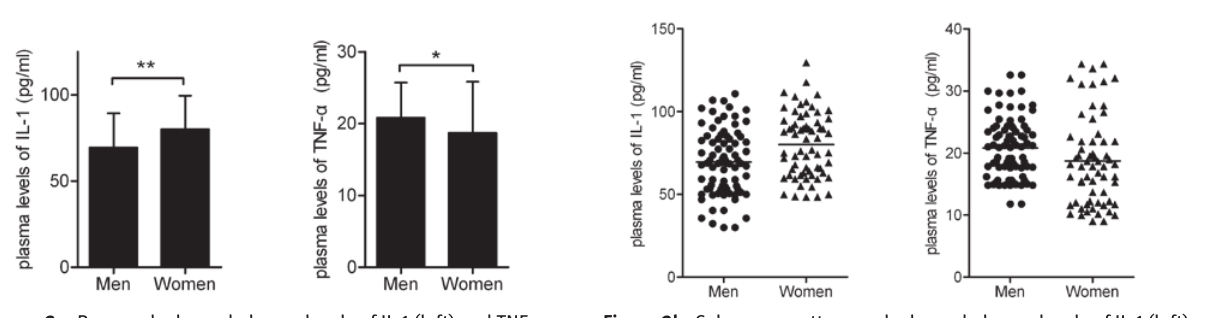
Figure 2a: Bar graph showed plasma levels of IL-1 (left) and TNF-α (right) of each gender, respectively. **P=0.002 VS men group for IL-1; *P=0.015 VS women group for TNF-α.